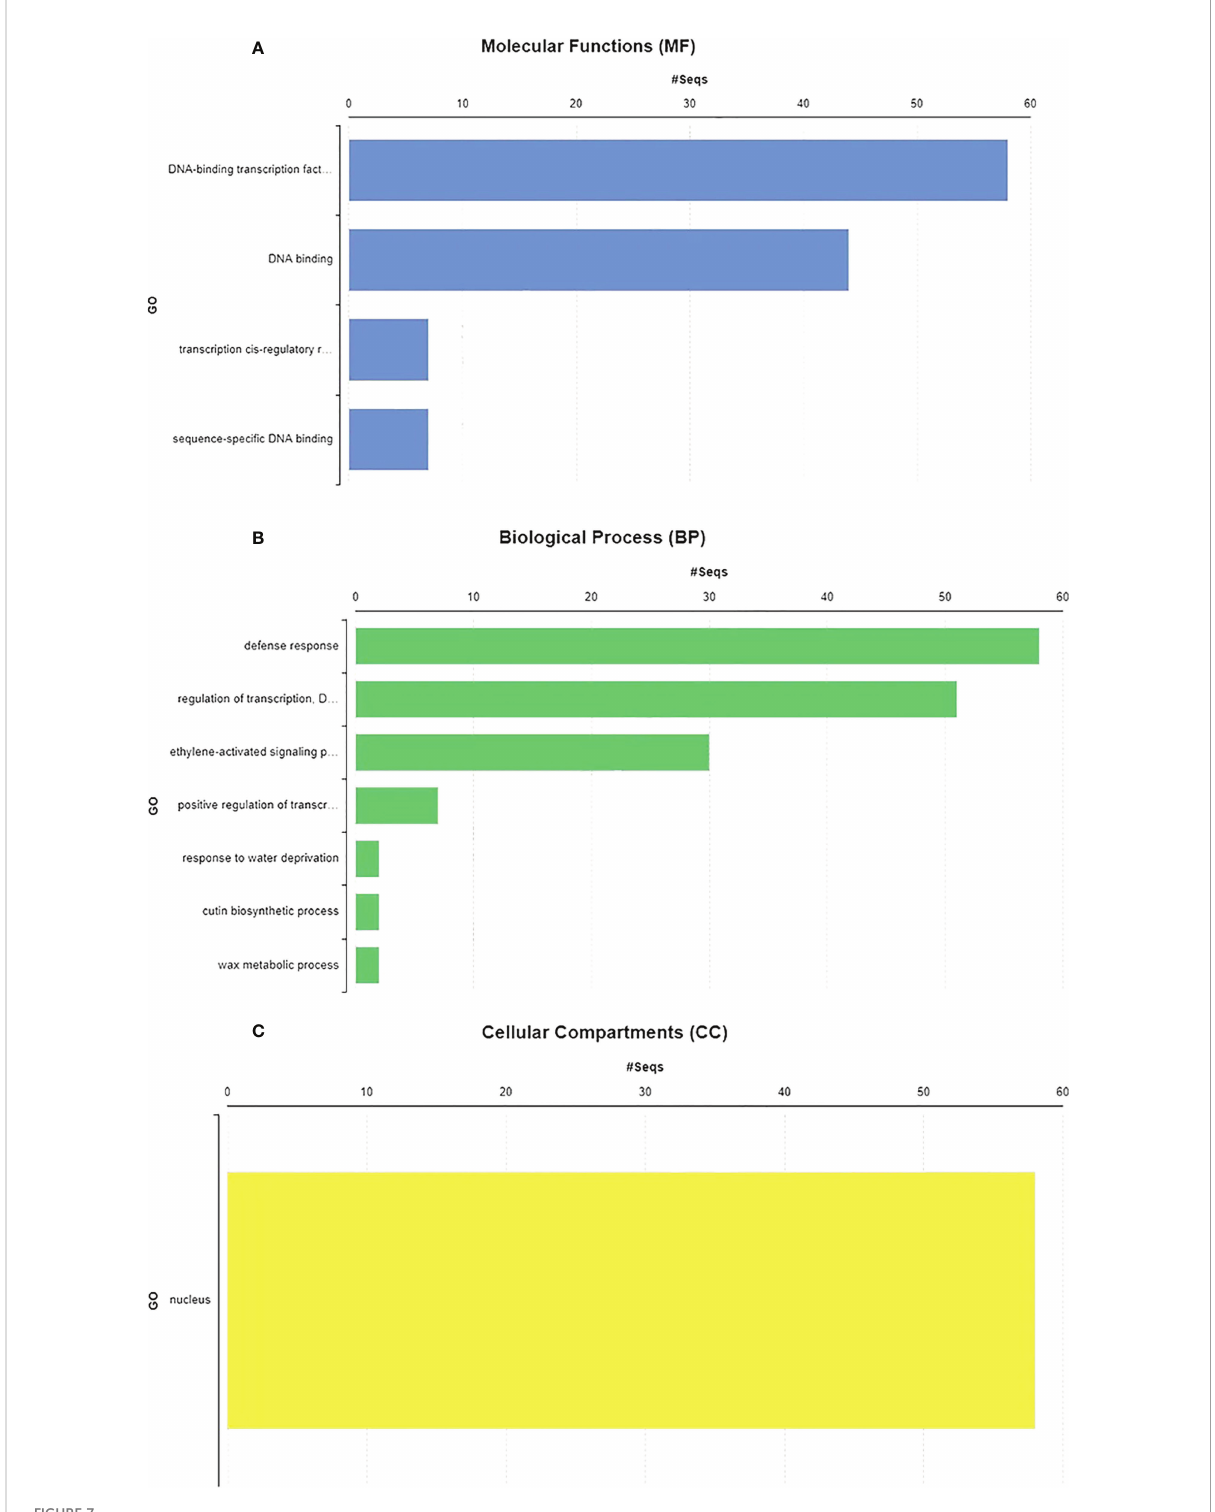
FIGURE 7 Gene ontology and functional analysis were performed by using Blast2GO software. (A) SlDREB genes involved in the respective molecular functions. (B) Biological processes conducted by these genes. (C) Cellular compartments comprised by SlDREB